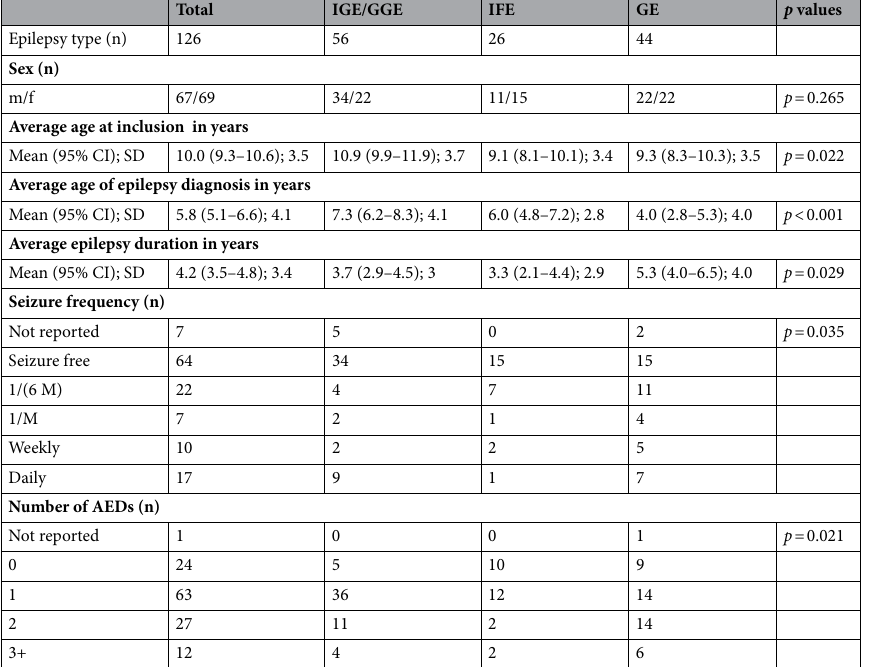
Table 1. Demographic data. IGE/GGE, idiopathic/genetic generalized epilepsy; IFE, idiopathic focal epilepsy; GE, genetic epilepsy; m, male; f, female; CI, confidence interval; SD, standard deviation; M, month(s); AED, antiepileptic drug.